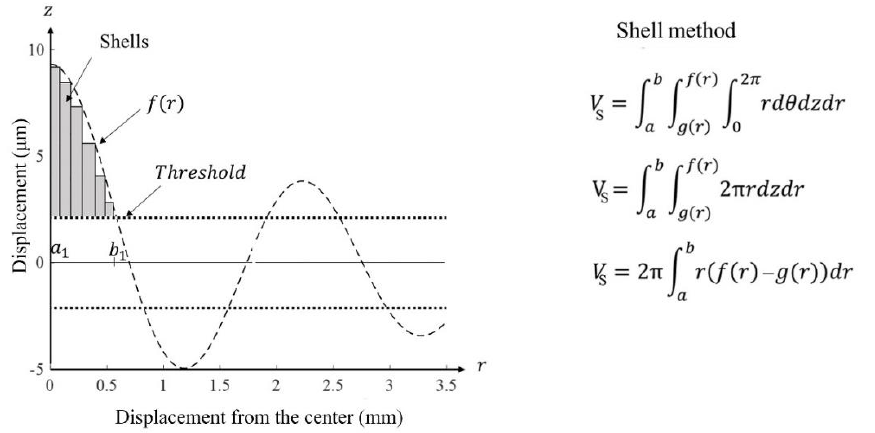
Figure 15. Approximation of the volume caused by the out-of-plane displacement distribution. On the left, the shell method for integration of the solid of the revolution about the z-axis is described. The function f ( r ) is integrated along r , with its value subtracted by the threshold function g ( r ) . According to our experimental findings, atomization was not detected below 20